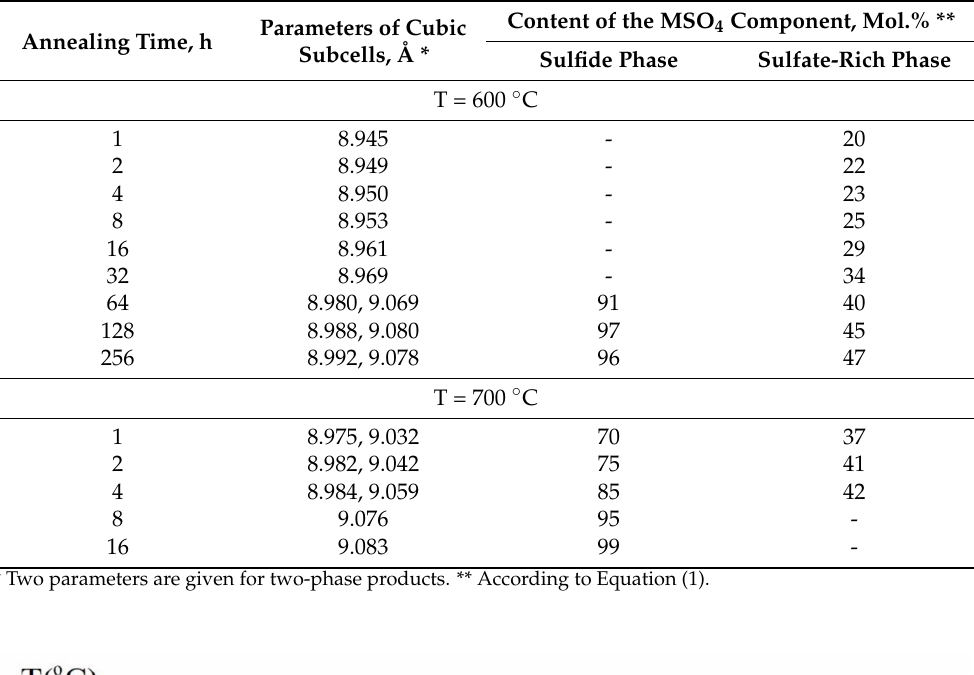
Table 6. Experimental data on thermal transformations during annealing of Sample 5 preheated over the Fe-FeS buffer.